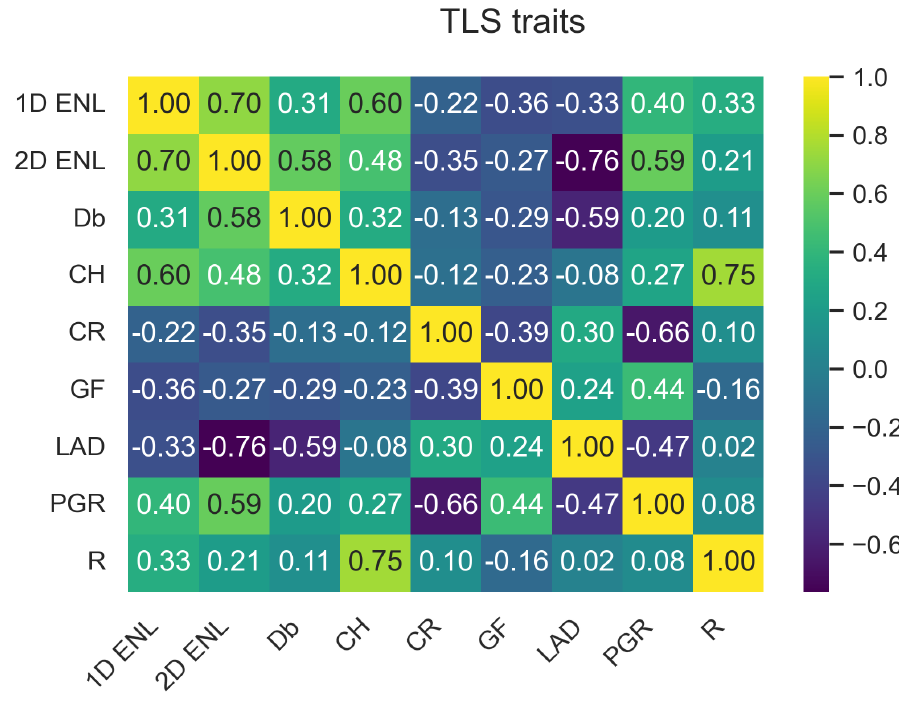
Figure A42. TLS correlation matrix at 5m grid